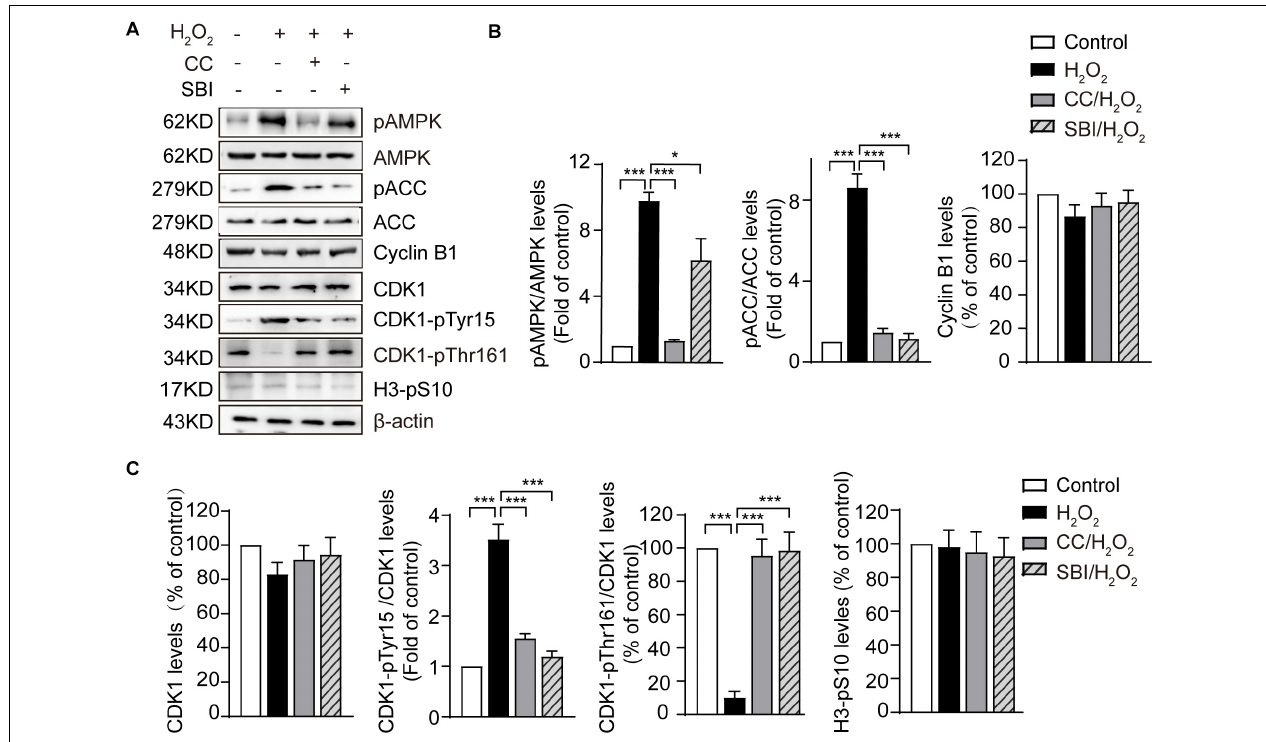
FIGURE 4 | Activated AMPK contributes to oxidative stress-induced inactivation of CDK1 in mouse zygotes. CC, Compound C; SBI, SBI-0206965. (A) Representative data showing the level of pAMPK, pACC, Cyclin B1, CDK1, CDK1-pTyr15 and CDK1-pThr161 in control, H 2 O 2 -treated, Compound C/H 2 O 2 -treated, and SBI-0206965/H 2 O 2 -treated zygotes in the G2 phase. (B,C) Quantification data of figure ( n = 3). Results were analyzed by one-way ANOVA and Tukey’s test. * p < 0.05; *** p < 0.001. Error bars: